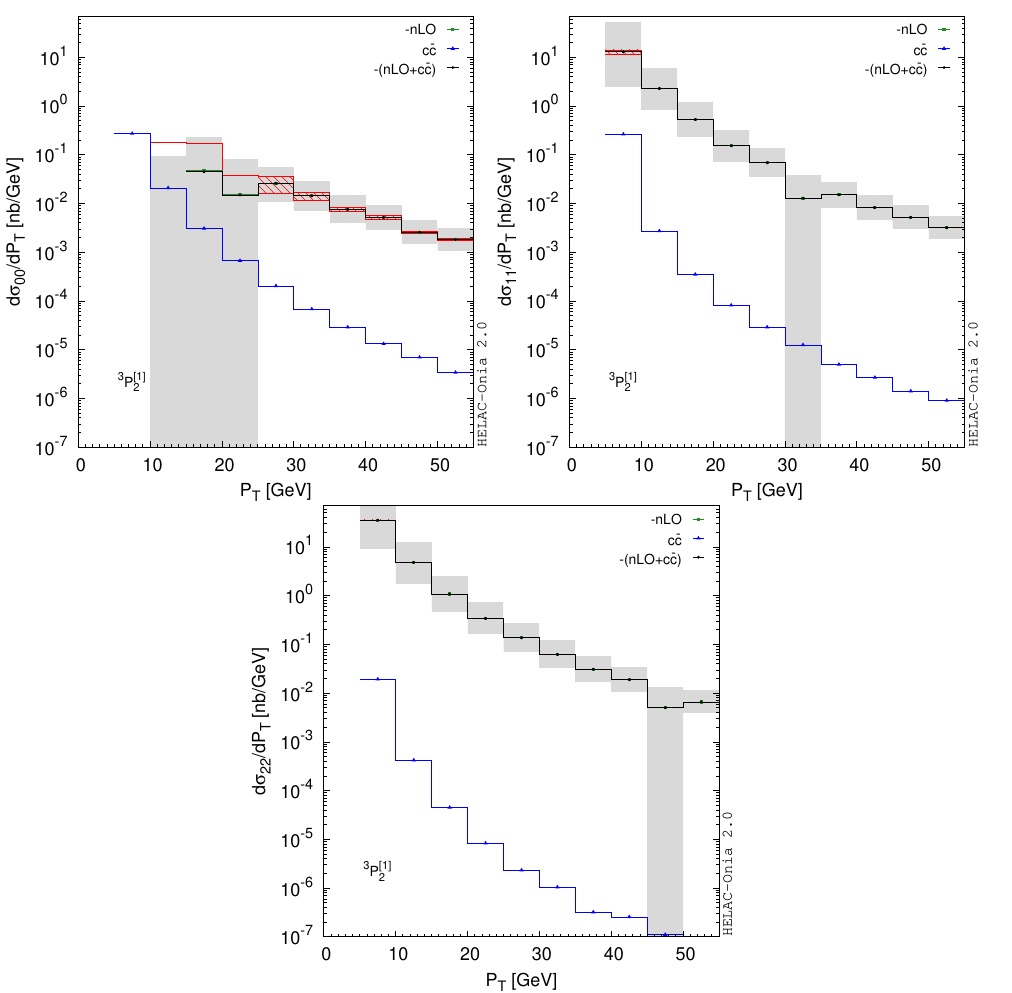
Figure 26 . Comparisons of spin-dependent differential cross sections d(cid:27) between our nLO calculations and the LO charmonium plus charm quark pair calculations. They are similar to figure